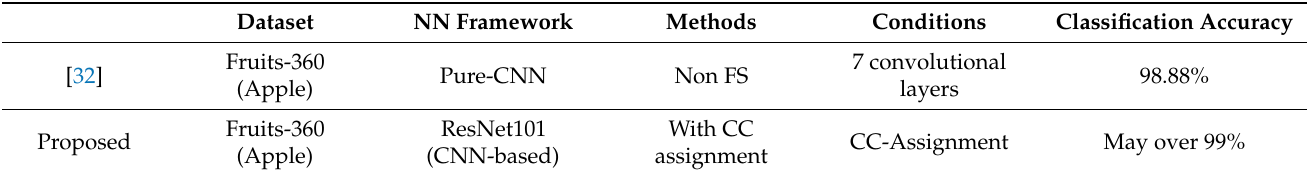
Table 4. A results comparison between the current proposed and othre work.